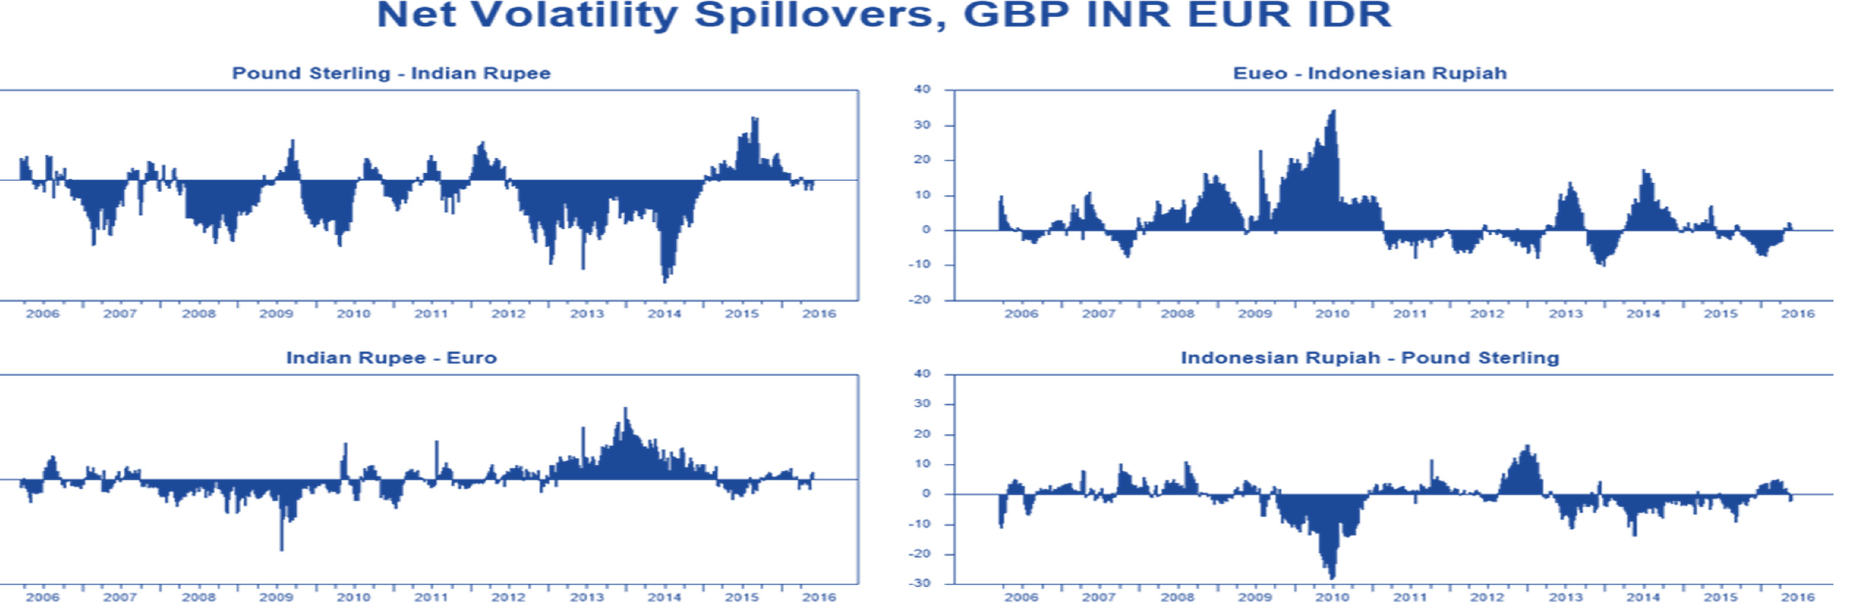
Figure 6. This figure shows the net volatility spillovers between developed and developing countries. In particular, the net volatility spillovers from/to the Pound Sterling (GBP), Indian Rupee (INR), Euro (EUR), and the Indonesian Rupiah (IDR).